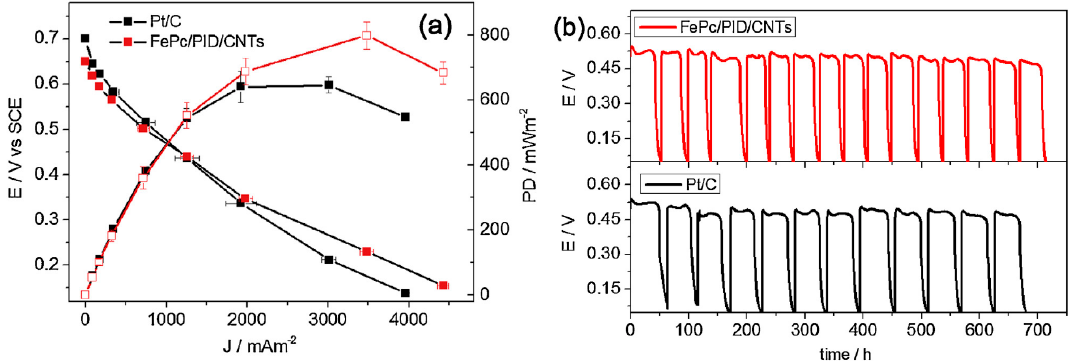
Figure 6. ( a ) Cell voltage and power density of MFCs assembled with FePc/PID/CNTs and Pt/C cathodes, and ( b ) voltage cycles under a 1 kV external resistance by MFCs assembled with FePc/PID/CNTs_CC and Pt/C_CC cathodes, recorded for 700 h after inoculation [105]. Iron(II) phthalocyanine (FePc) and cobalt tetramethoxyphenylporphyrin (CoTMPP)-based